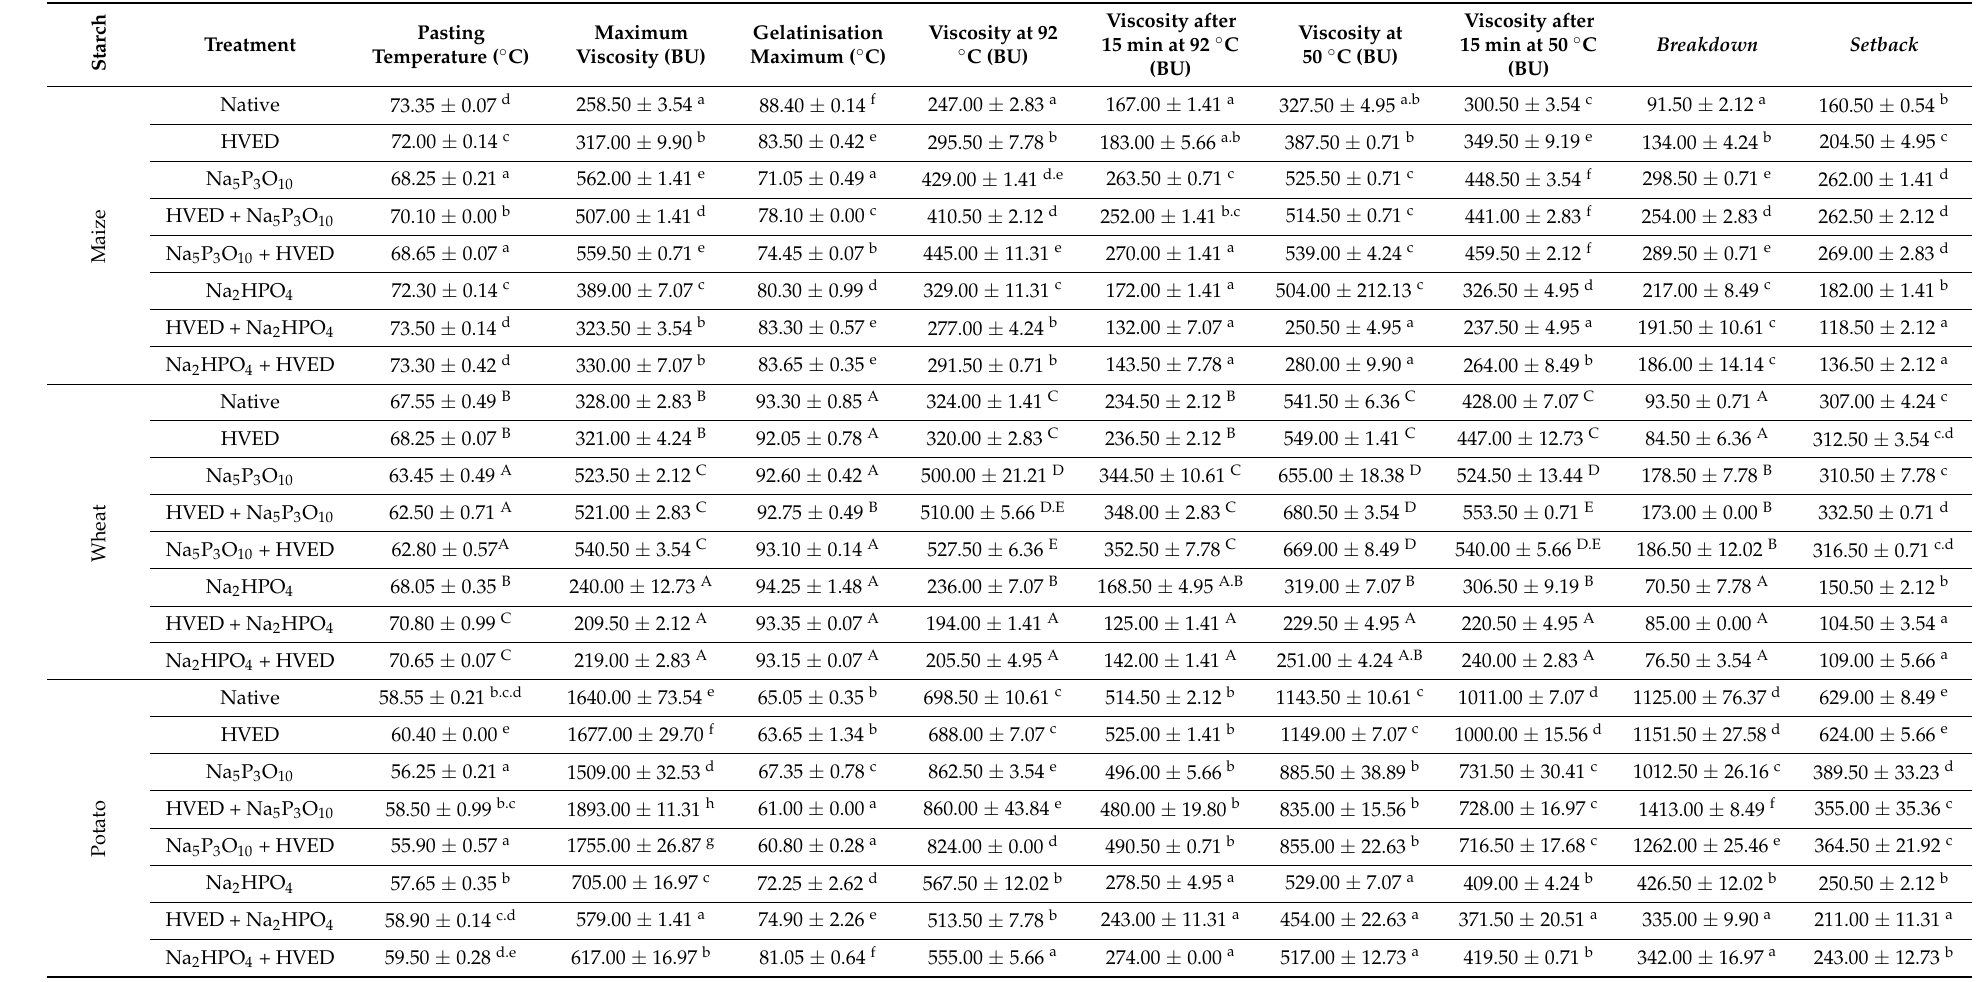
Table 1. Pasting properties of native and modified